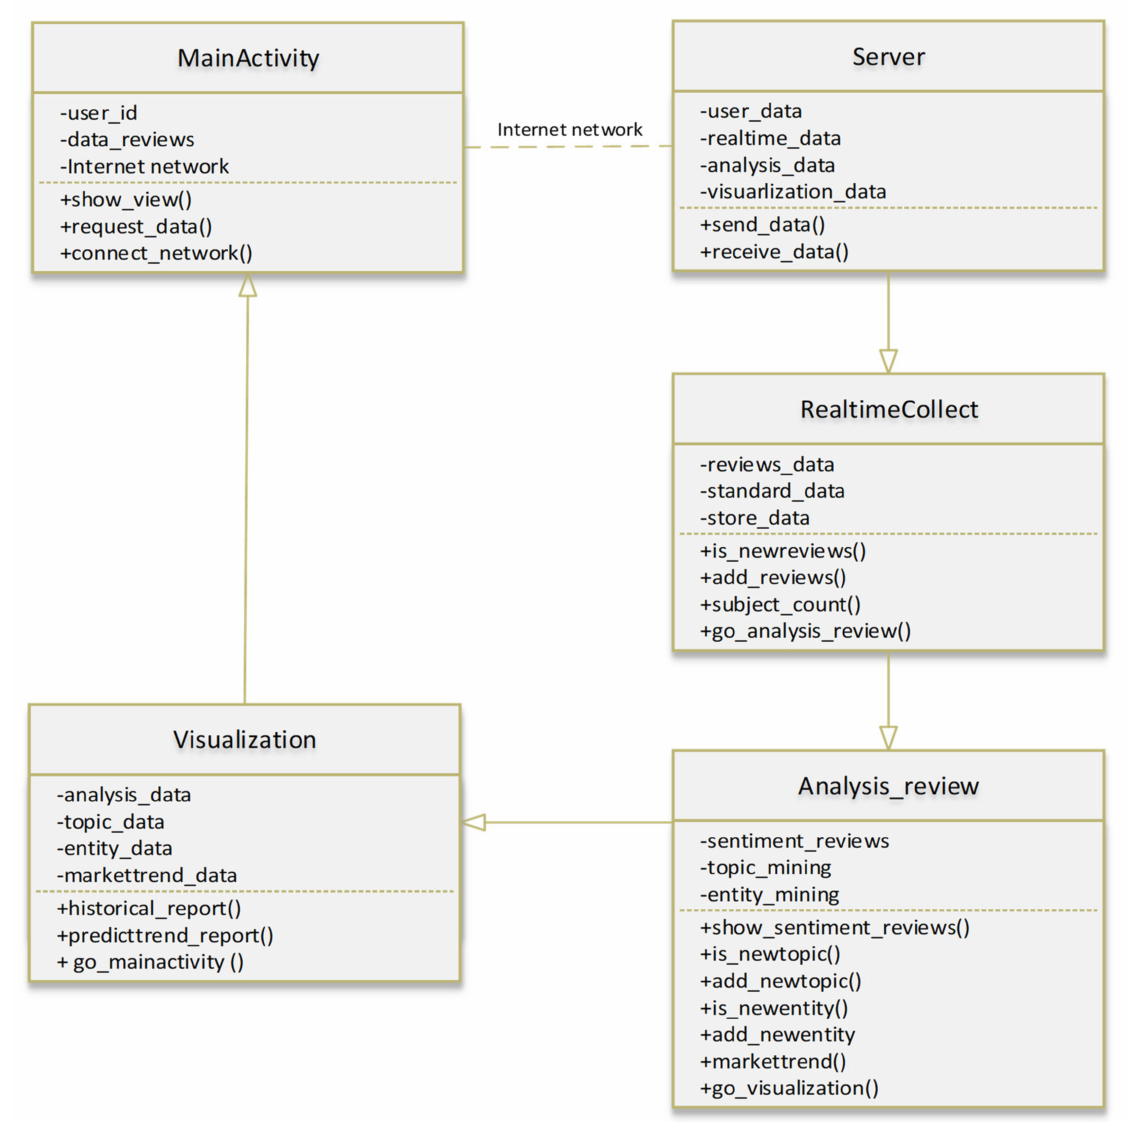
Figure 9. The UML of Sentiment Product Reviews